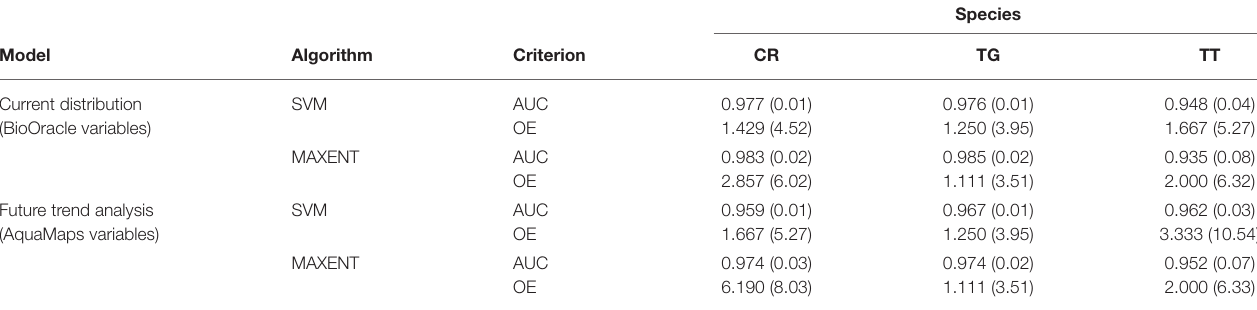
TABLE 3 | Results of model tests for all models of current distribution (based on Bio-Oracle and tidal variables) and future trend analysis (based on AquaMaps variables).